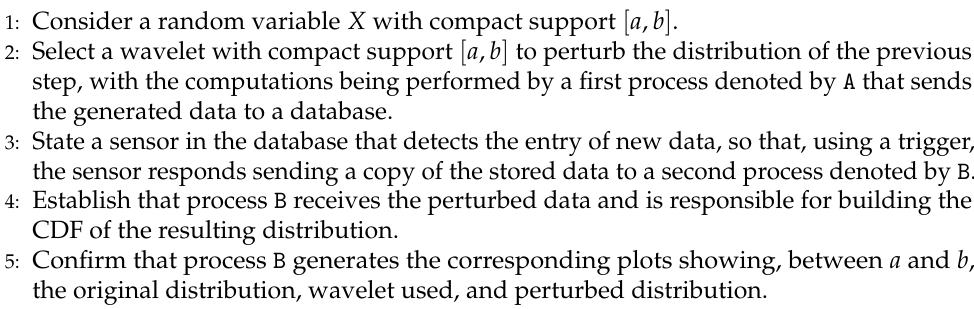
Algorithm 1 Approach to perturb a probability distribution with a database-sensor.